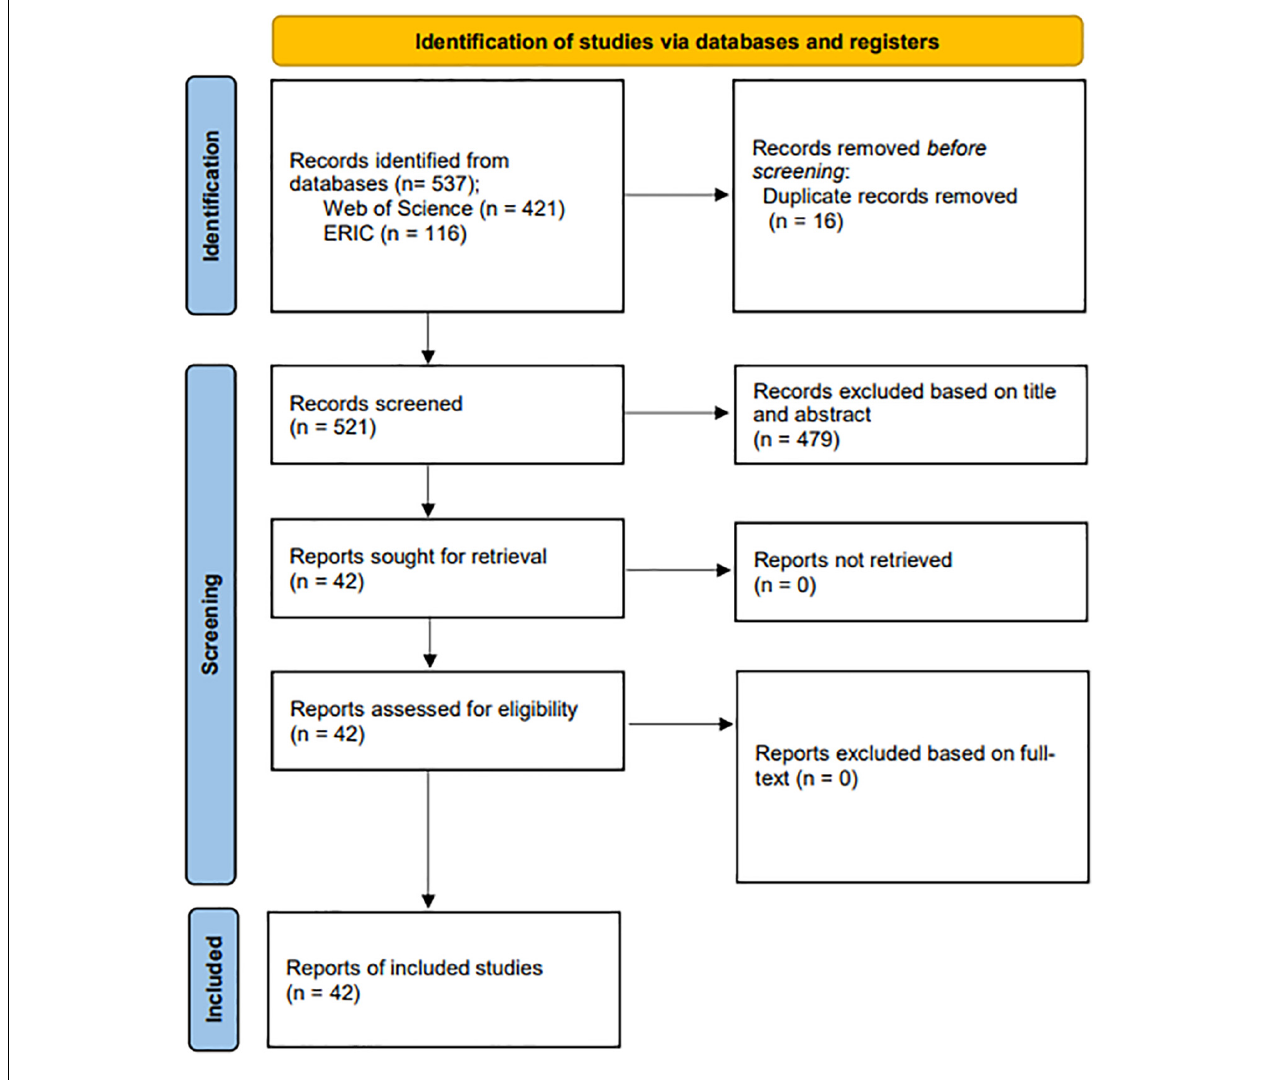
FIGURE 2 | English language articles’ selection